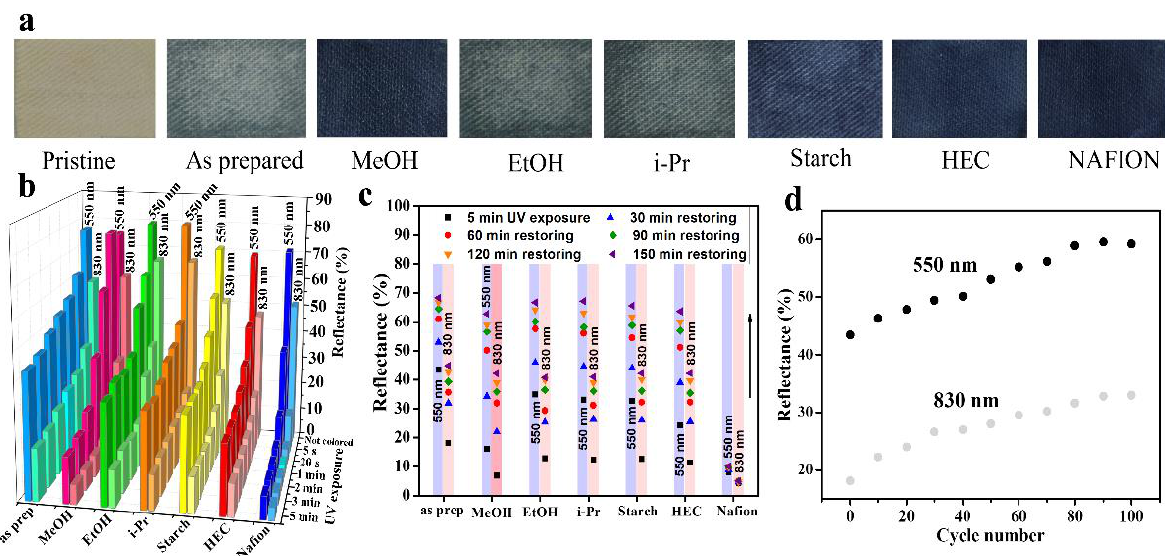
Figure 4. ( a ) Pictures of soaked or over-coated textile sample previously functionalized with NC solution of WO 3-x :TiO 2 (25% WO 3-x ) and UV irradiated for 5 min. ( b ) Representative reflectance values during coloring process with different UV exposure and ( c ) and bleaching process carried out after 5 min of UV irradiation and recorded at different time intervals for λ = 550 nm and λ = 830 nm on soaked or over-coated textile’s sample previously functionalized with NC solution containing WO 3-x :TiO 2 (1:3). ( d ) Cycling property of HEC over-coated WO 3-x :TiO 2 (25% WO 3-x ) textile exposed to 100 cycles of 5 min UV irradiation followed by 5 min heated at 75 °C.